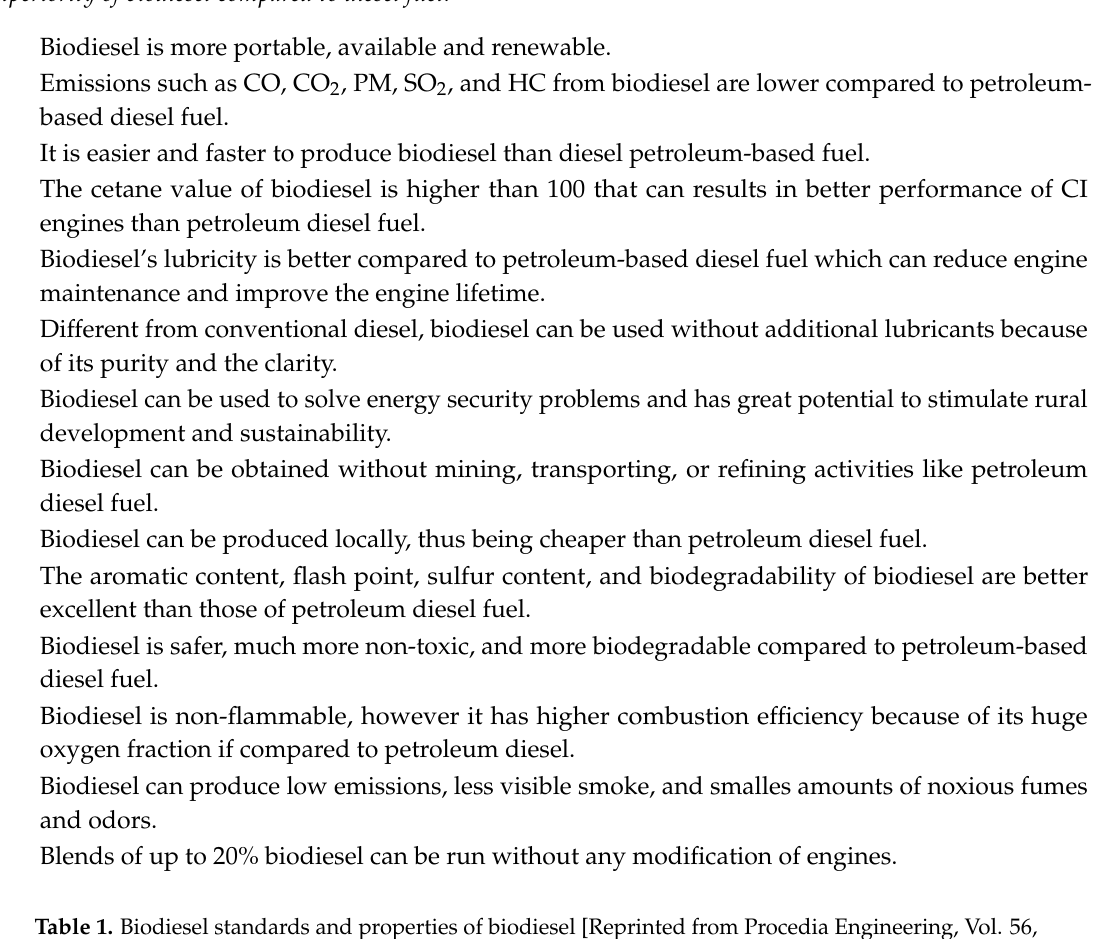
Table 1. Biodiesel standards and properties of biodiesel [Reprinted from Procedia Engineering, Vol. 56, Masjuki Hj. Hassan, Md. Abul Kalam, An Overview of Biofuel as a Renewable Energy Source: Development and Challenges, Copyrights (2013); with permission from